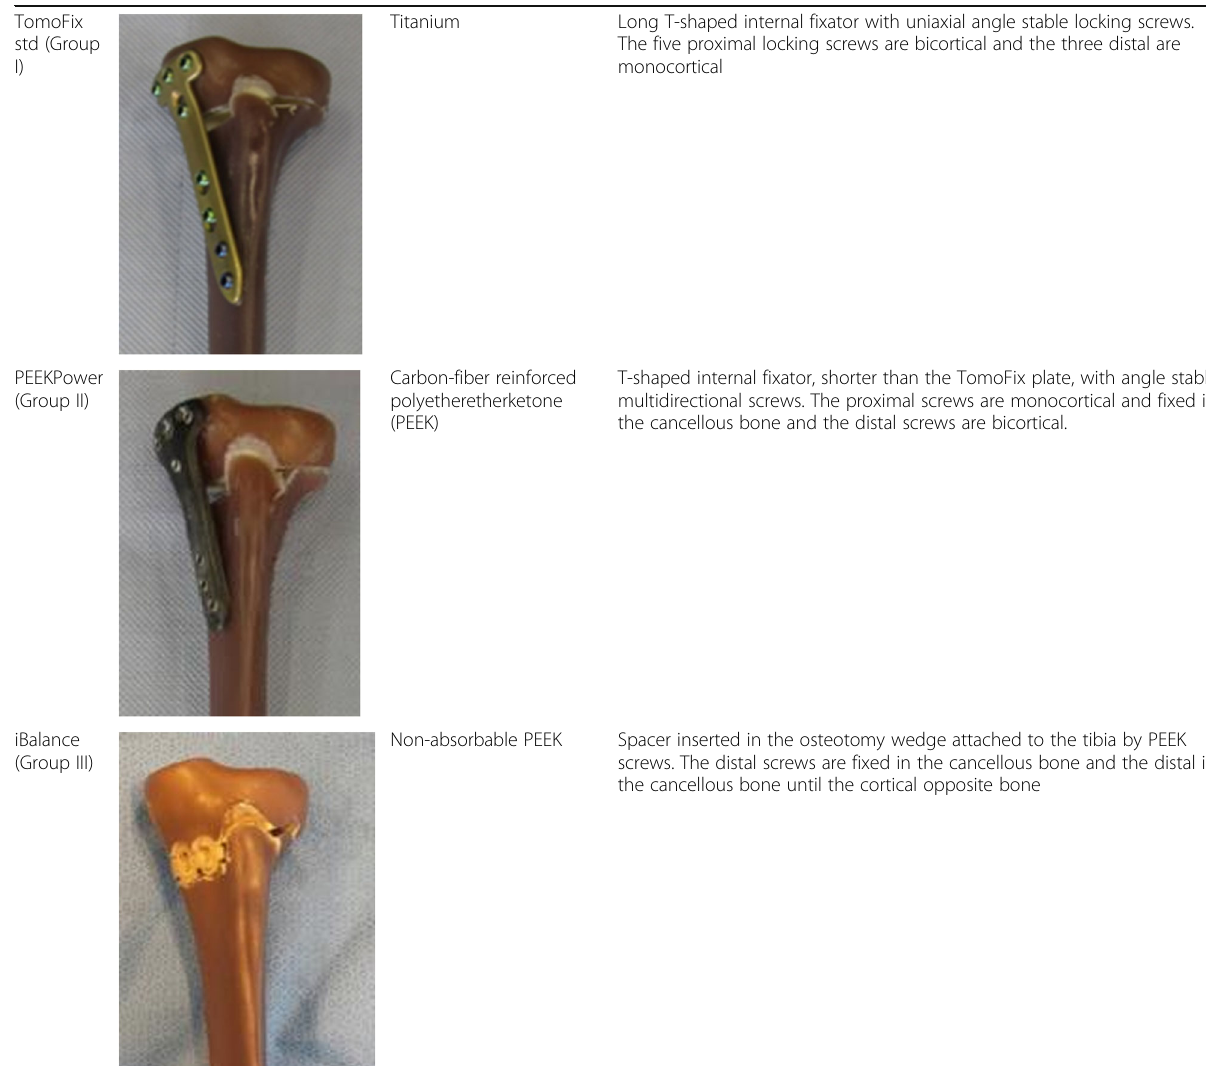
Table 1 Different HTO implants considered in the study (Groups I, II and III) Groups Implant